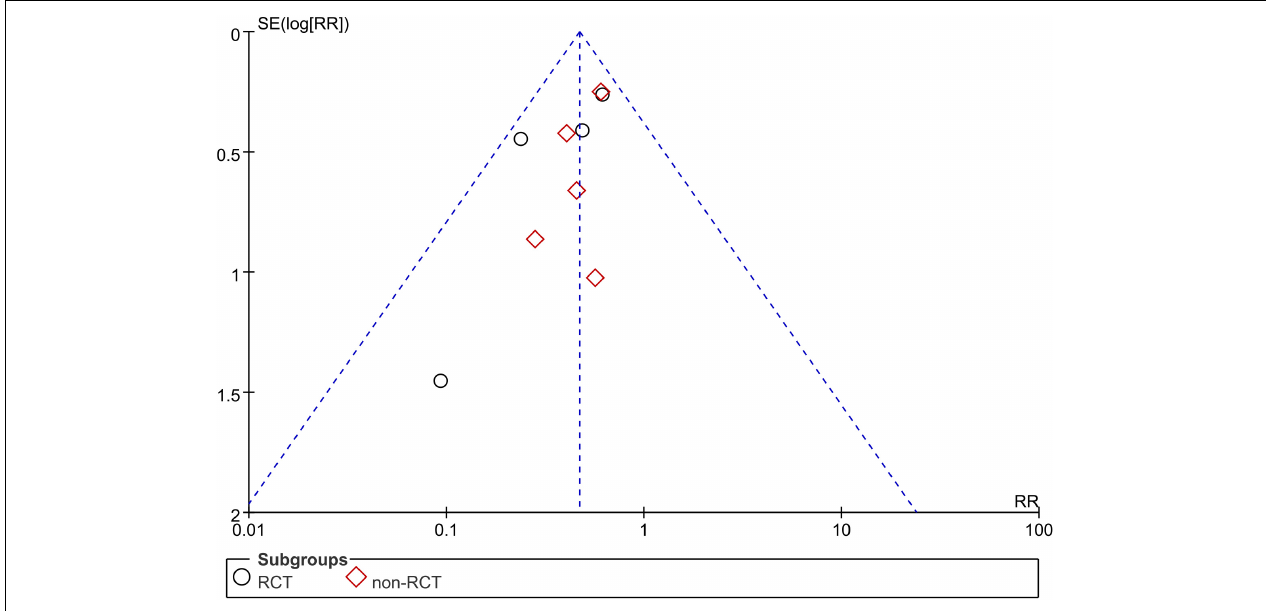
FIGURE 7 | Funnel plot of publication bias of recurrence